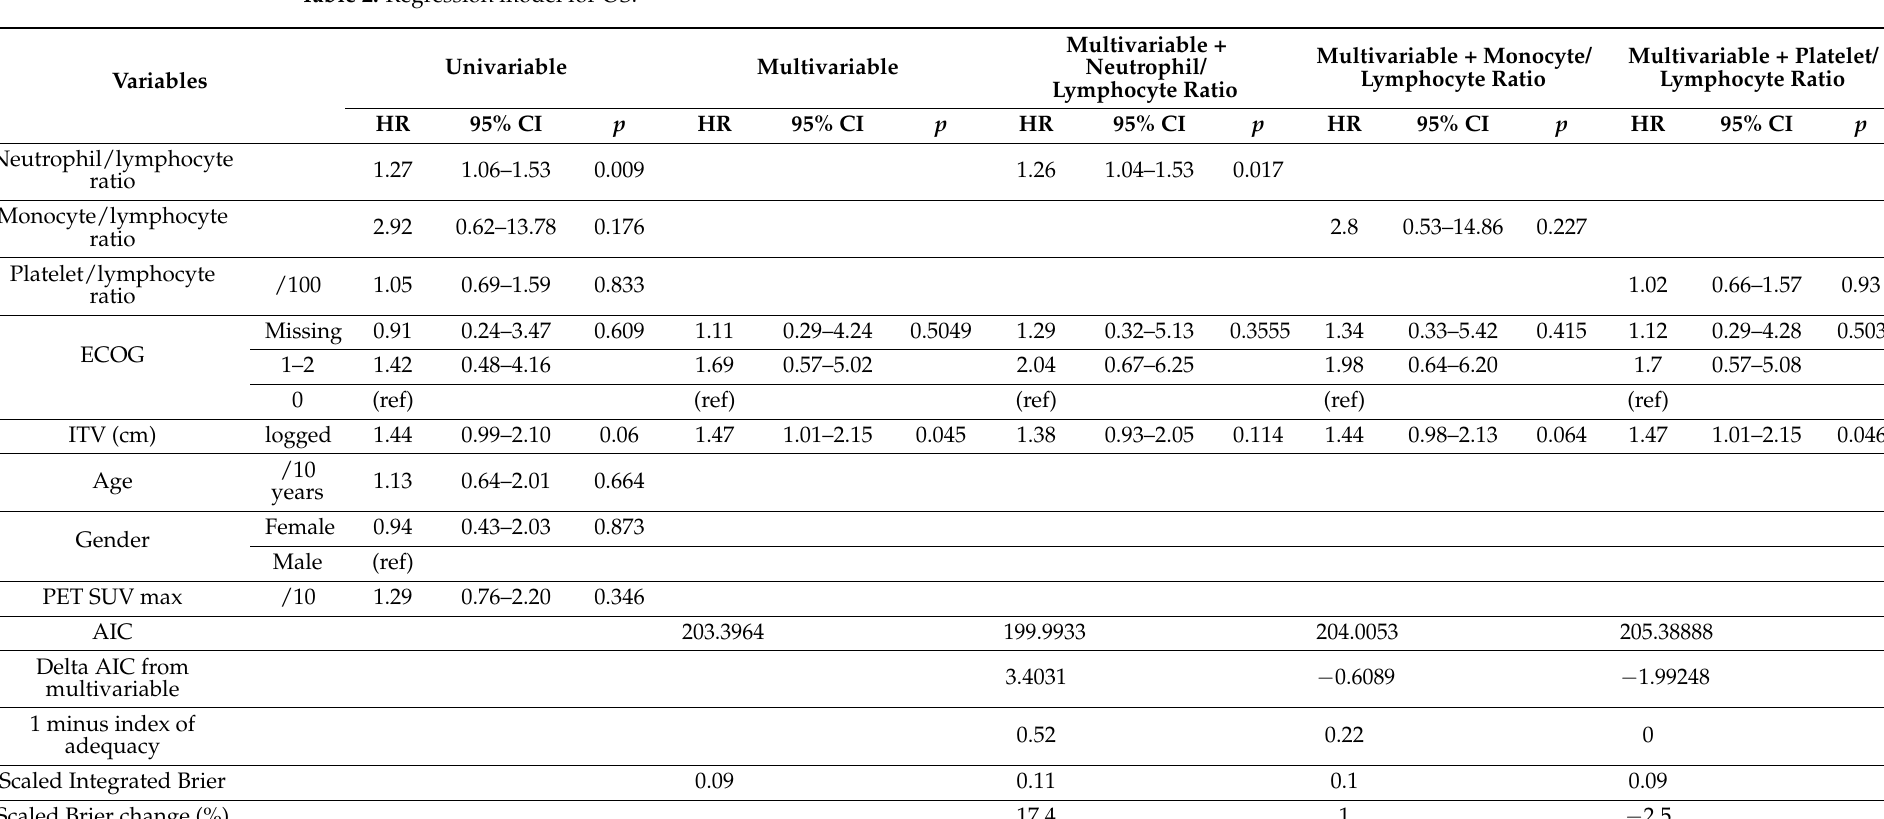
Table 2. Regression model for